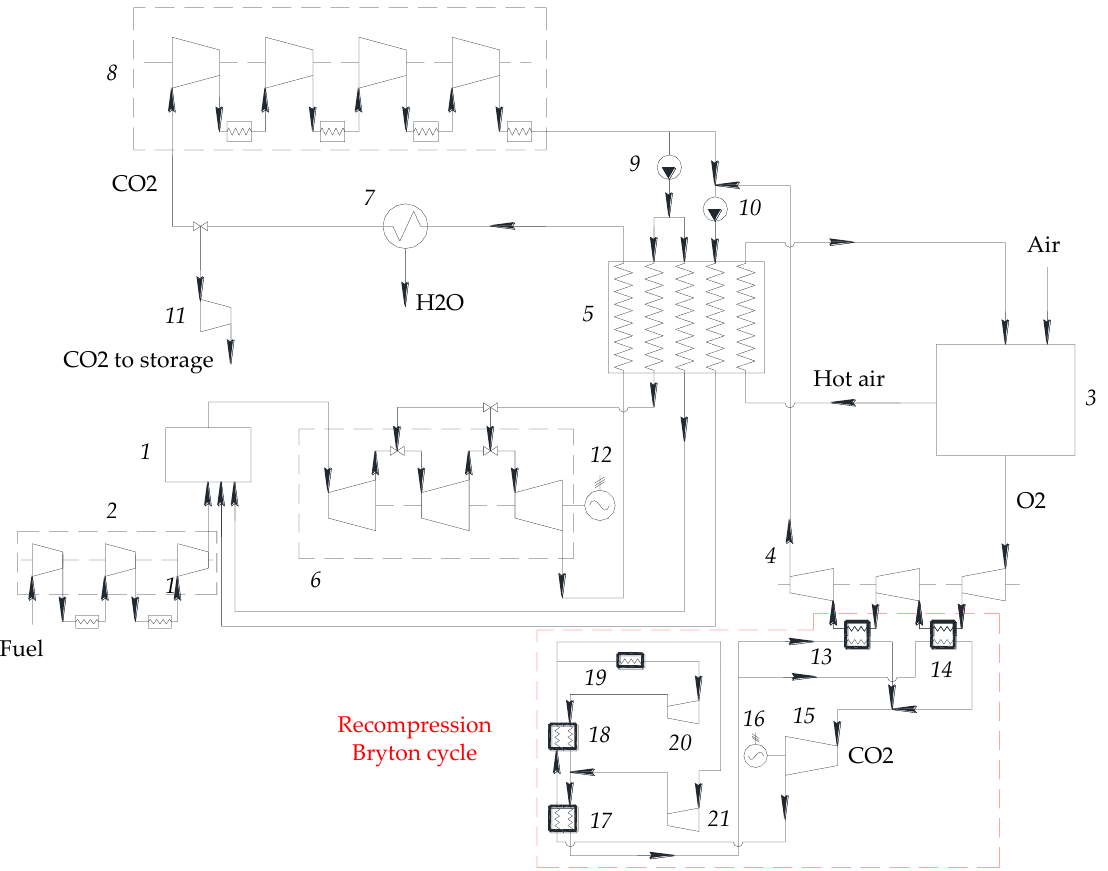
Figure 10. The Allam cycle utilizing the low-potential heat of compressed oxygen in a S – CO 2 recompression Brayton cycle.